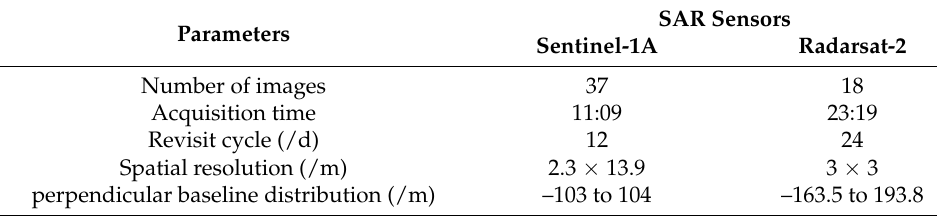
Table 3. MERRA-2, ERA-I, and ERA-5